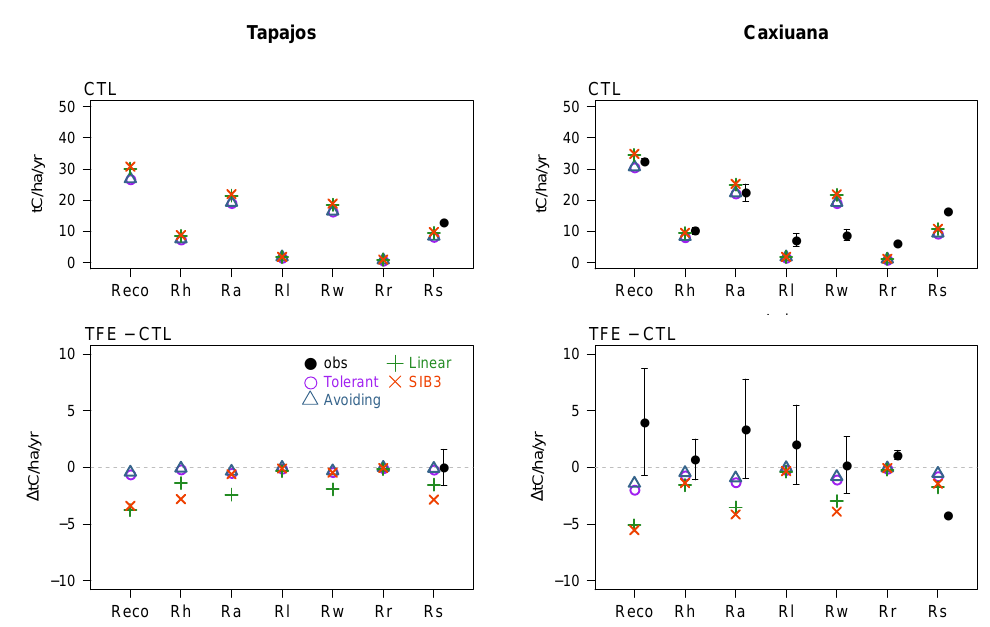
Figure 8. Annual ecosystem ( R ECO ) , heterotrophic ( R H ) , autotrophic ( R A ) , leaf ( R l ) , wood ( R w ) , root ( R r ) and soil ( R s ) respirations for the fourth year of the experiment for the control plot (top) and the difference between the exclusion and control plot (bottom) at Tapajós (left) and Caxiuanã (right).